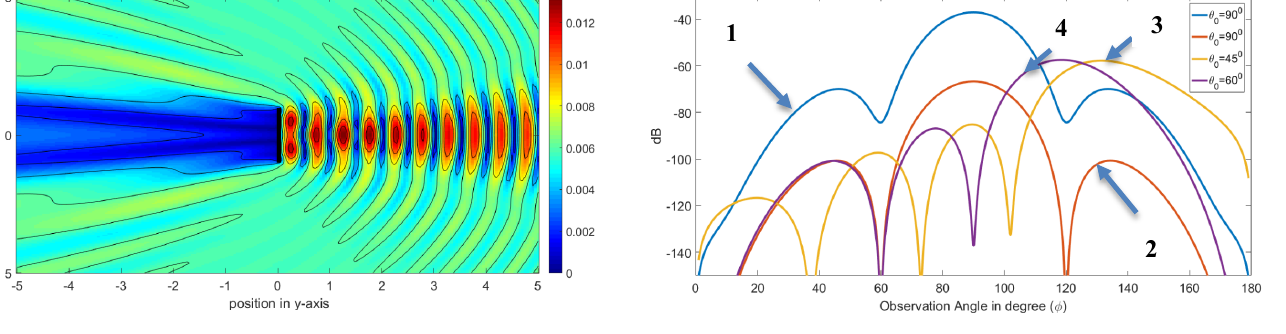
Figure 9: Bi-static Radar Cross Section for 𝜖 = 2𝜋 In Fig. 10, 11 and 12, the normalized current density are shown for the different 𝜖 and the source position 𝜌 location of the source line and the angle with respect to strip are given in order. Arrows 1, 2 and 3 are responsible for 𝜃 = 90 F , 𝜃 = 40 F , 𝜃 = 60 F , respectively. F F F